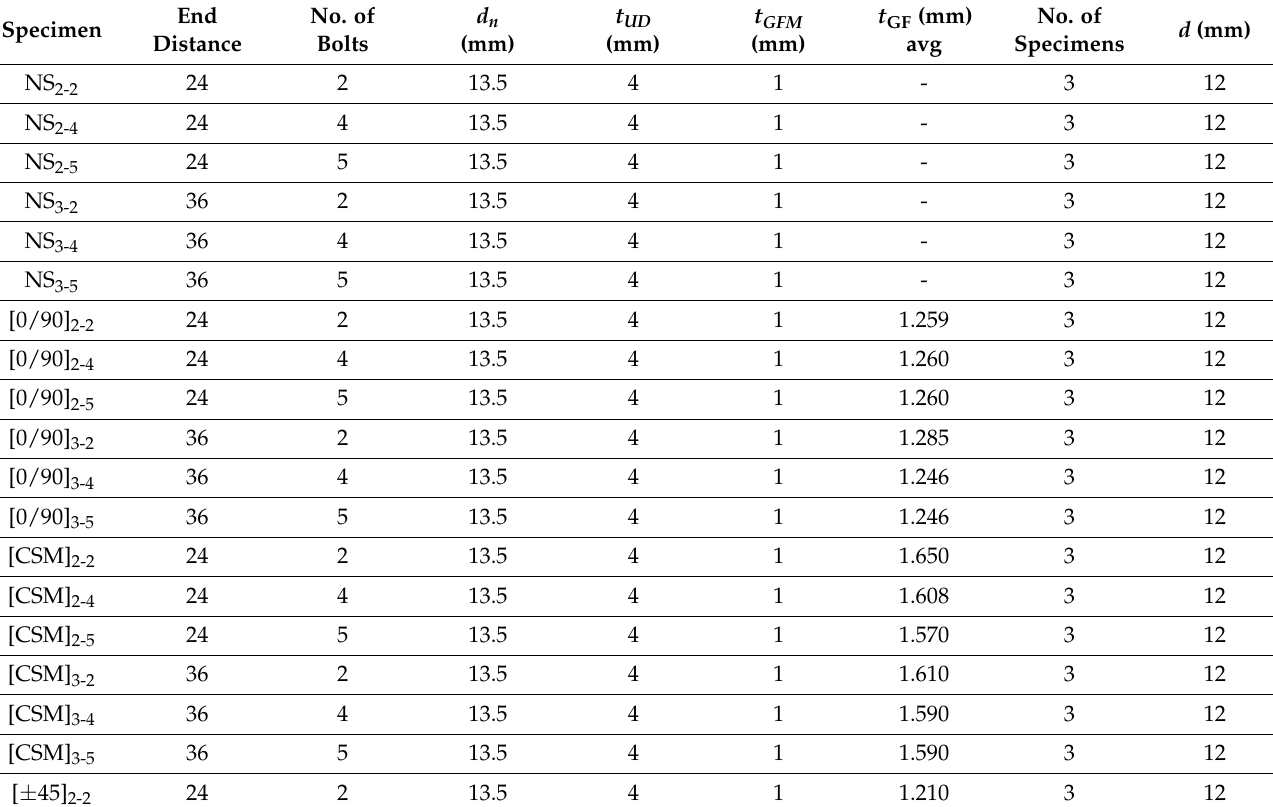
Table 2. Test program for PGFRP